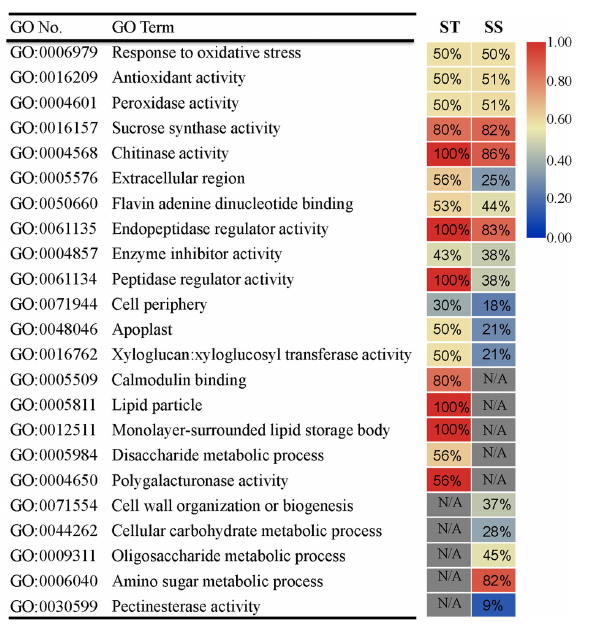
activity”), indicating that these biological processes may be basic responses to salinity stress across genotypes ( Figure 3 ). Notably, some common GO terms had different DEG expression trends.